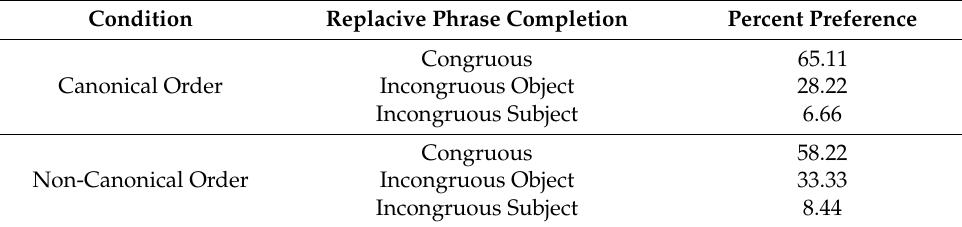
Table 1. Mean Percentages of (In)Congruous Completions for the Replacive Phrase Region. Condition Replacive Phrase Completion Canonical